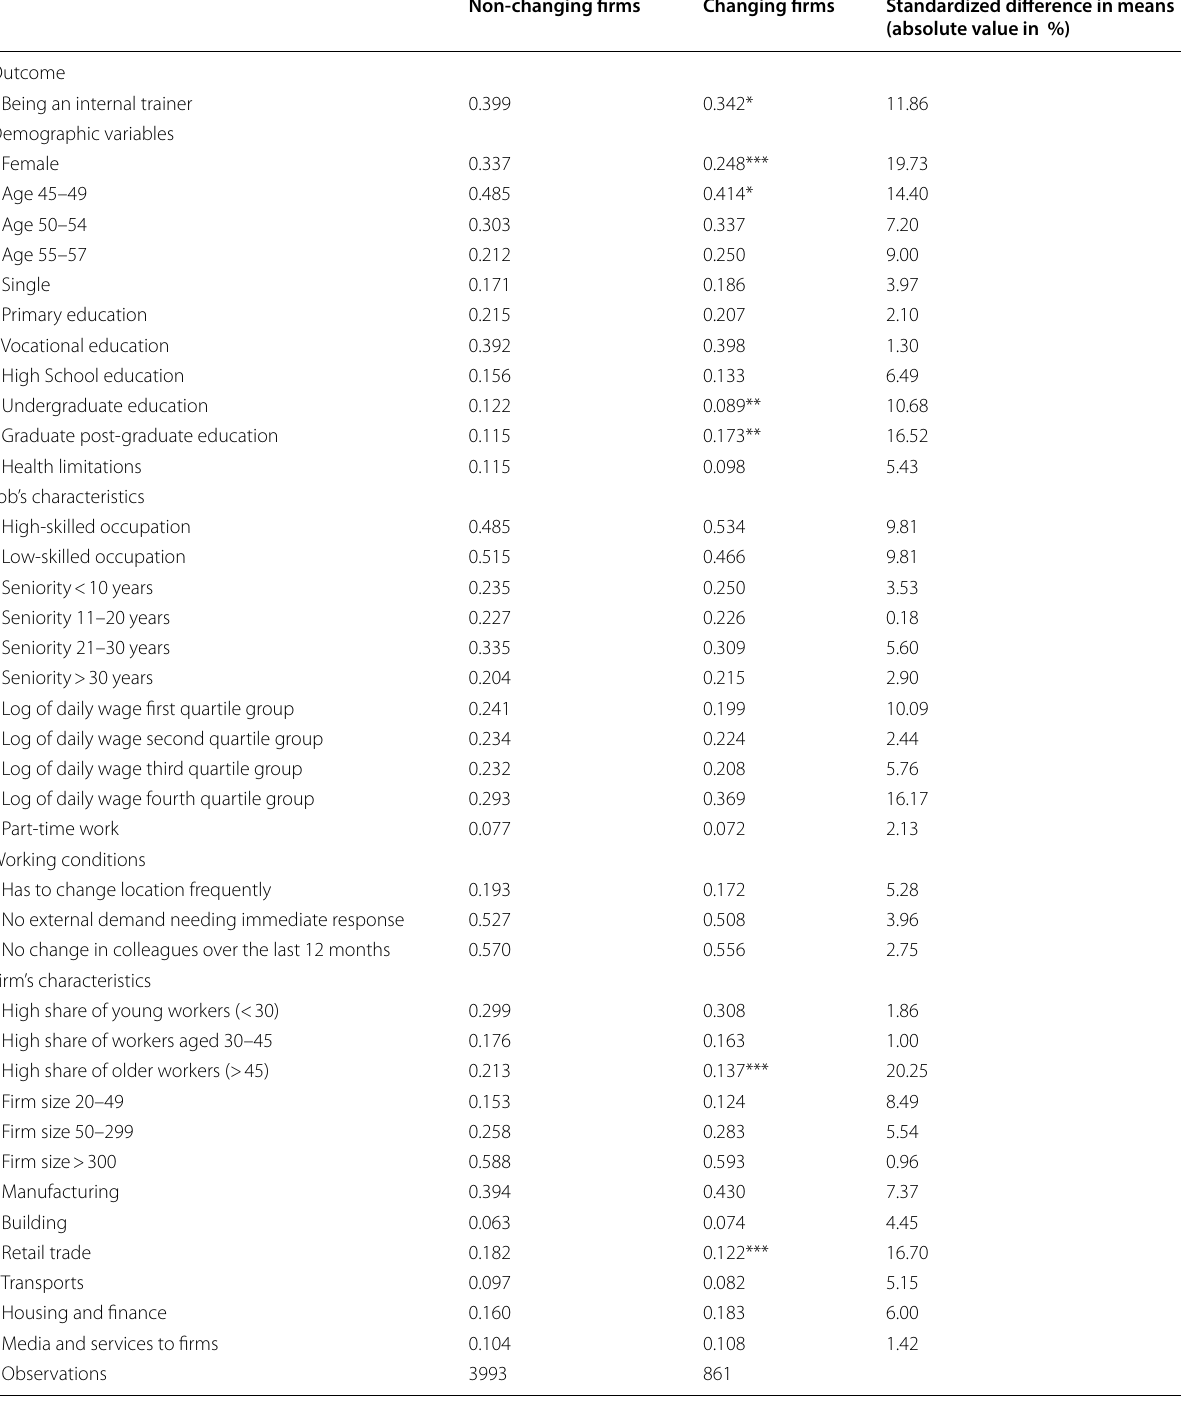
Table 3 Descriptive statistics of workers employed in a changing or non-changing